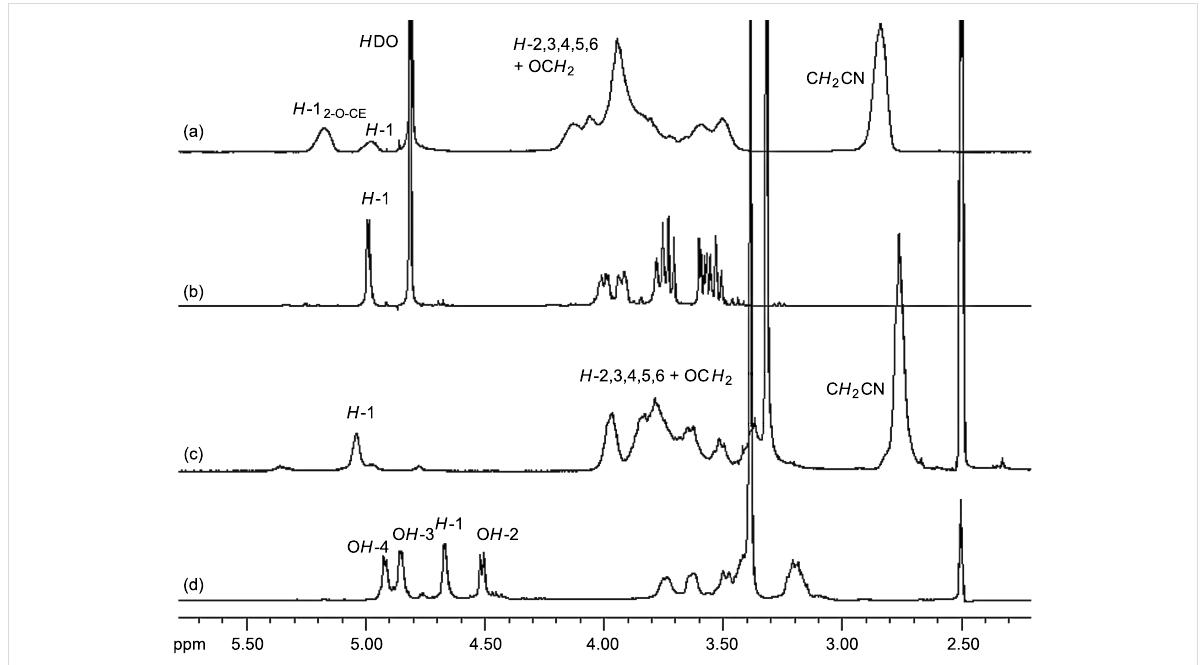
Figure 4: 1 H NMR spectra (300 MHz) of (a) CED-2 (DS NMR(1) = 1.81) in D 2 O; (b) dextran, native in D 2 O; (c) CED-3 (DS NMR(1) = 2.37) in DMSO- d 6 ; (d) dextran, native in DMSO- d 6 ; calibrated with solvent signals.